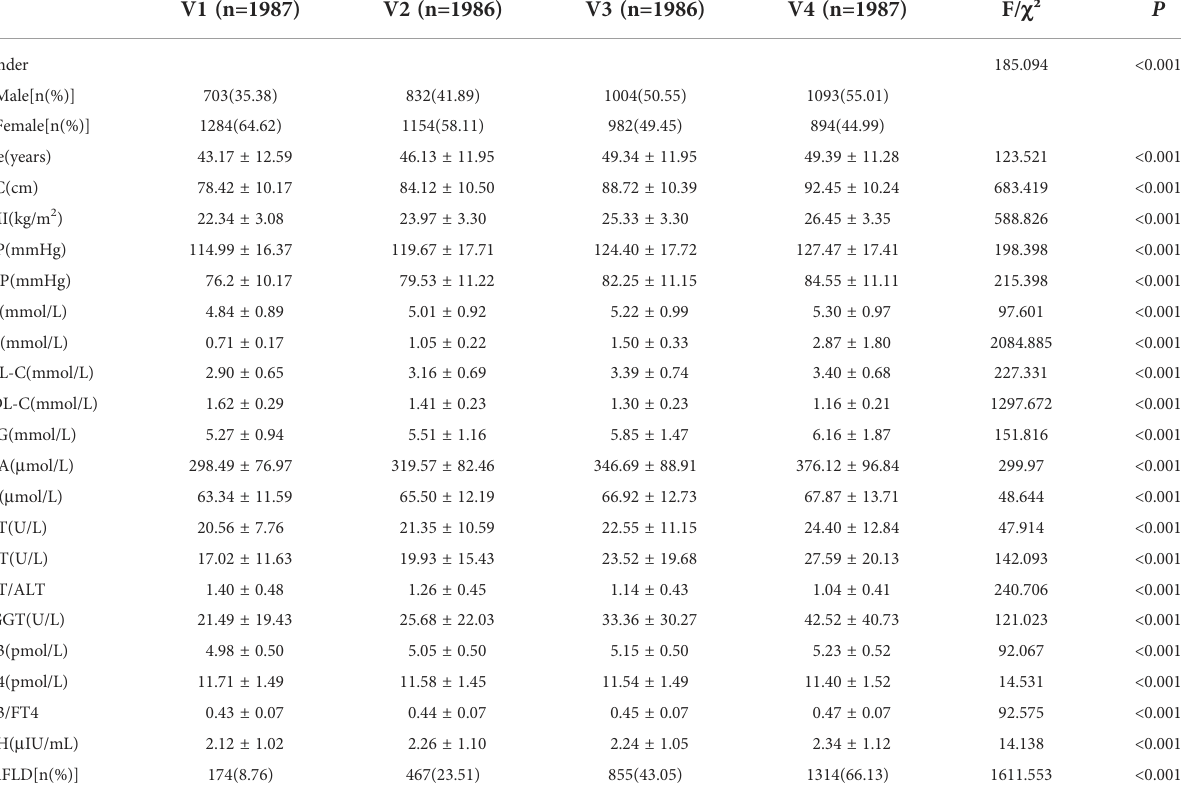
TABLE 2 Comparison of basic demographic characteristics of physical examinees with normal thyroid function in quartile groups of visceral adiposity index. V1